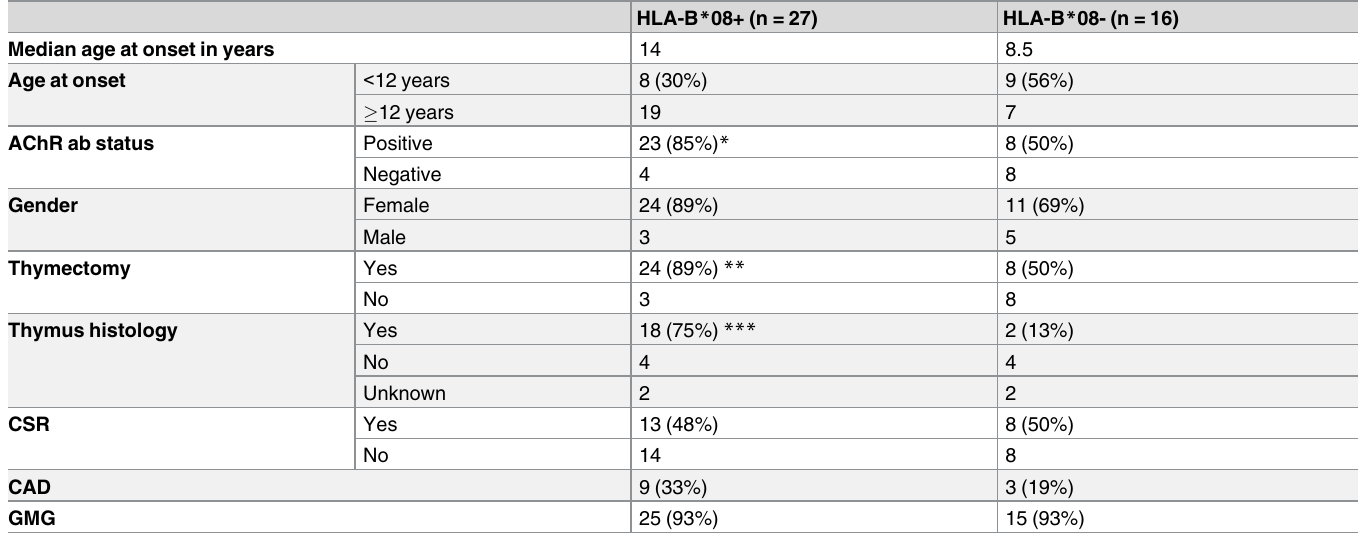
Table 3. Clinical characteristics of the juvenile myasthenia gravis cohort stratified by HLA-B * 08association.